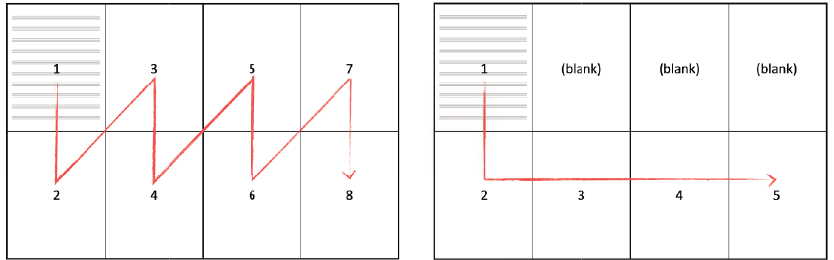
Fig. 3 Diagrams for reading directions in a part-score. On the left (fi gure 3.1) a general pattern, on the right (fi gure 3.2) the pattern used by Kolisch on fol. 4v-5r (showing pp. 24–28, mm. 1–43 of the third movement, the